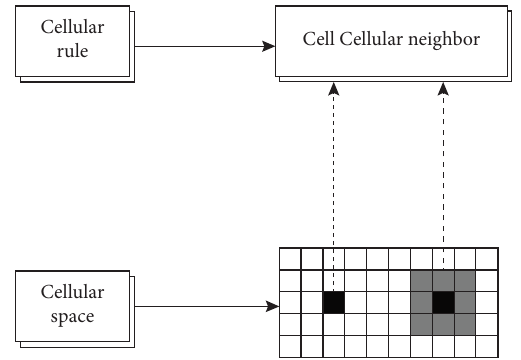
Figure 9: Cellular automata composition